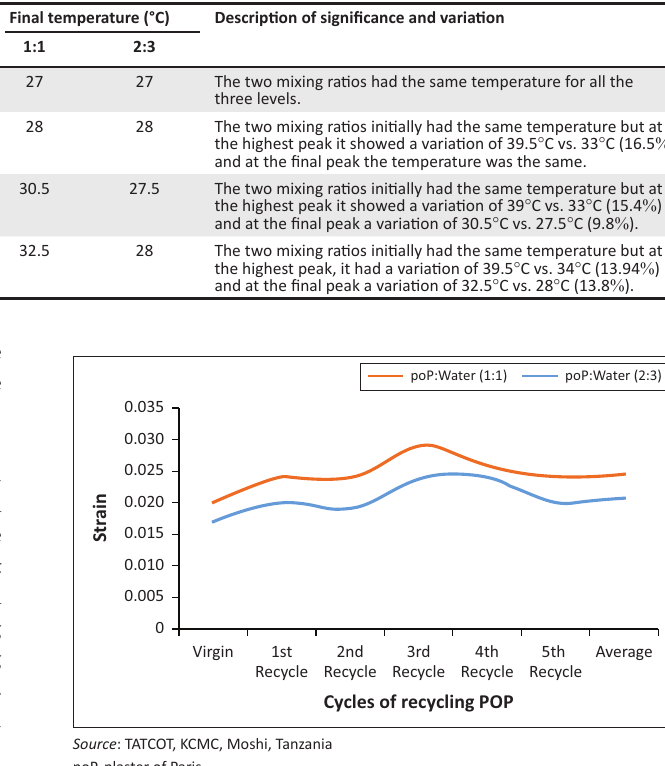
FIGURE 14: Plaster of Paris recycling